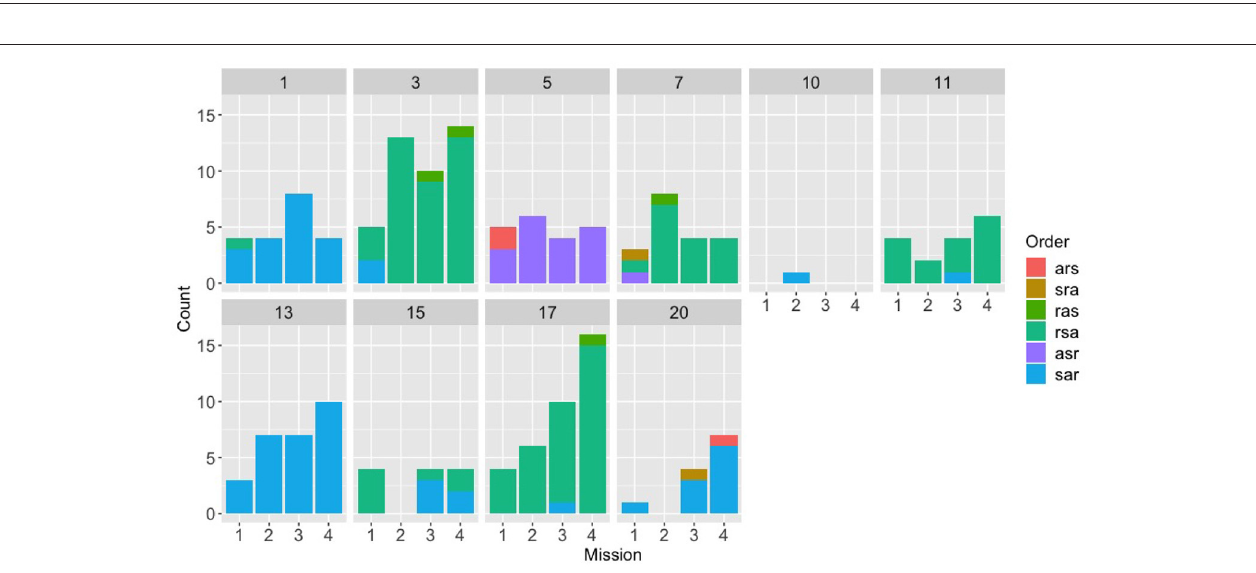
FIGURE 5 | Counts for each of the six possible orders for (s)peed, (a)ltitude, and (r)adius, across the first four missions for the speech experiment, broken down by team.